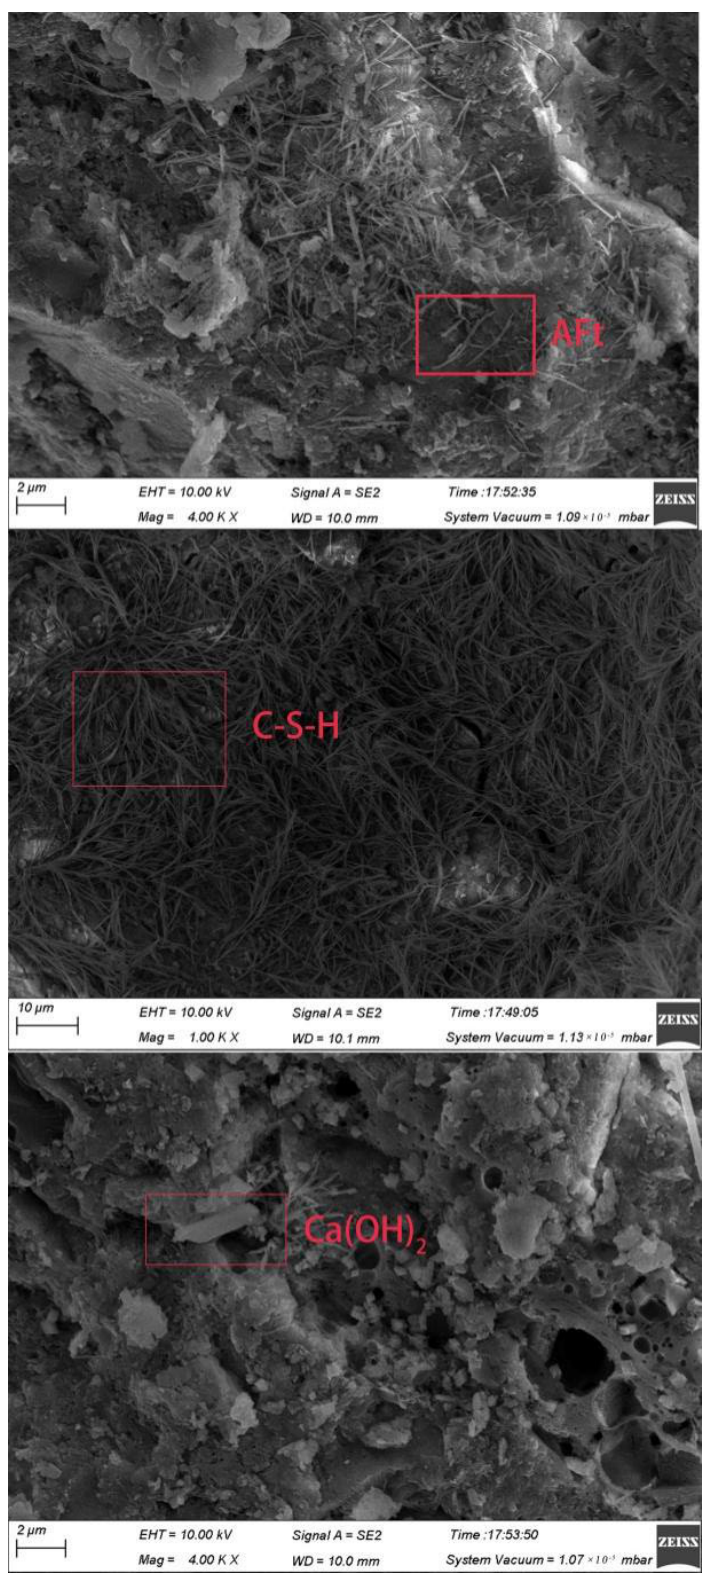
Figure 18. SEM images of OPC-LCFA sample at 28 days.